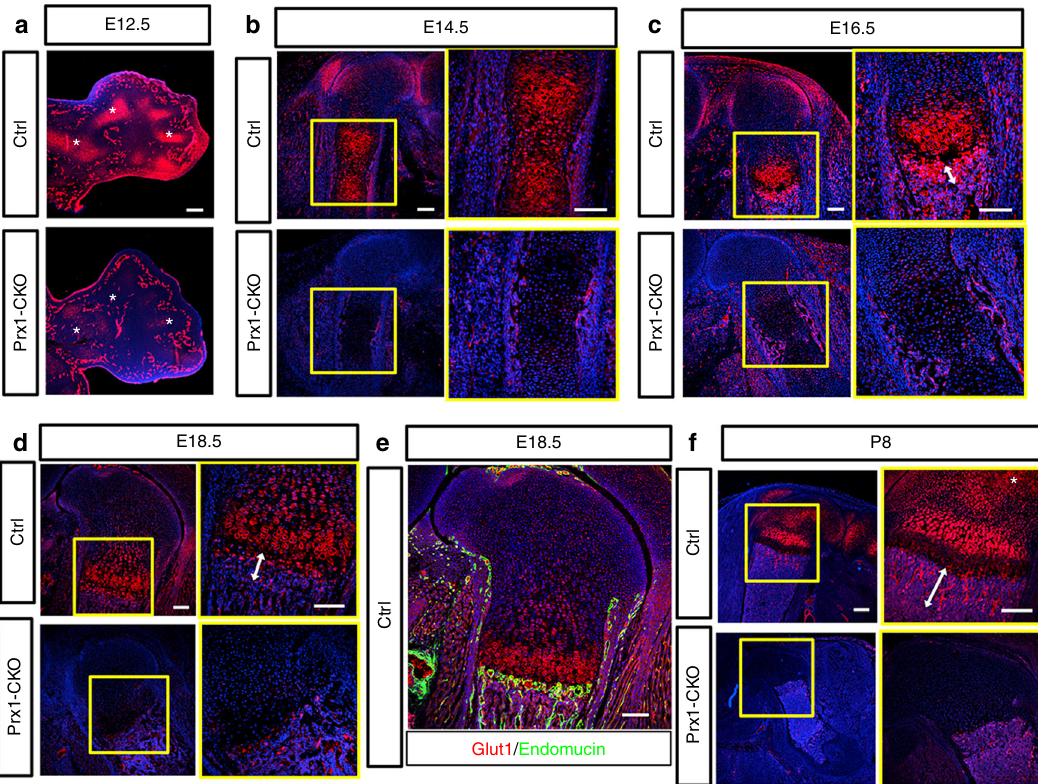
Fig. 1 Genetic deletion with Prx1-Cre eliminates Glut1 in the long bones of the mouse. a Immuno fl uorescence staining for Glut1 on longitudinal sections of the forelimbs of E12.5 control (Ctrl) or mutant littermates (Prx1-CKO). Asterisk denotes cartilage elements. Note comparable expression in the vasculature between control and mutant embryos. b – f Glut1 immunostaining on longitudinal sections of the femur of littermate control or mutant embryos at E14.5 ( b ), E16.5 ( c ), E18.5 ( d , e ), and P8 ( f ). Boxed areas are shown at higher magni fi cation to the right. Endomucin immunostaining in green marks endothelial cells ( e ). Double arrowheads denote trabecular bone region ( c , d , f ). Scale bar: 100 µ m ( a – e ) or 200 µ m ( f ). Each image is representative of three